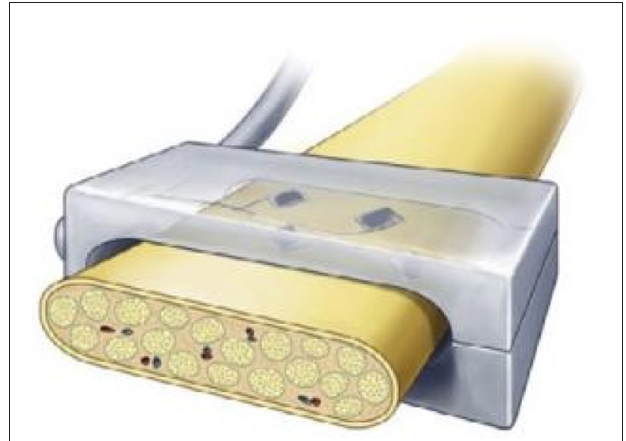
FIGURE 2 | A schematic drawing of a Flat Interface Nerve Electrode (FINE). Figure reproduced with permission from Graczyk et al. (2016).